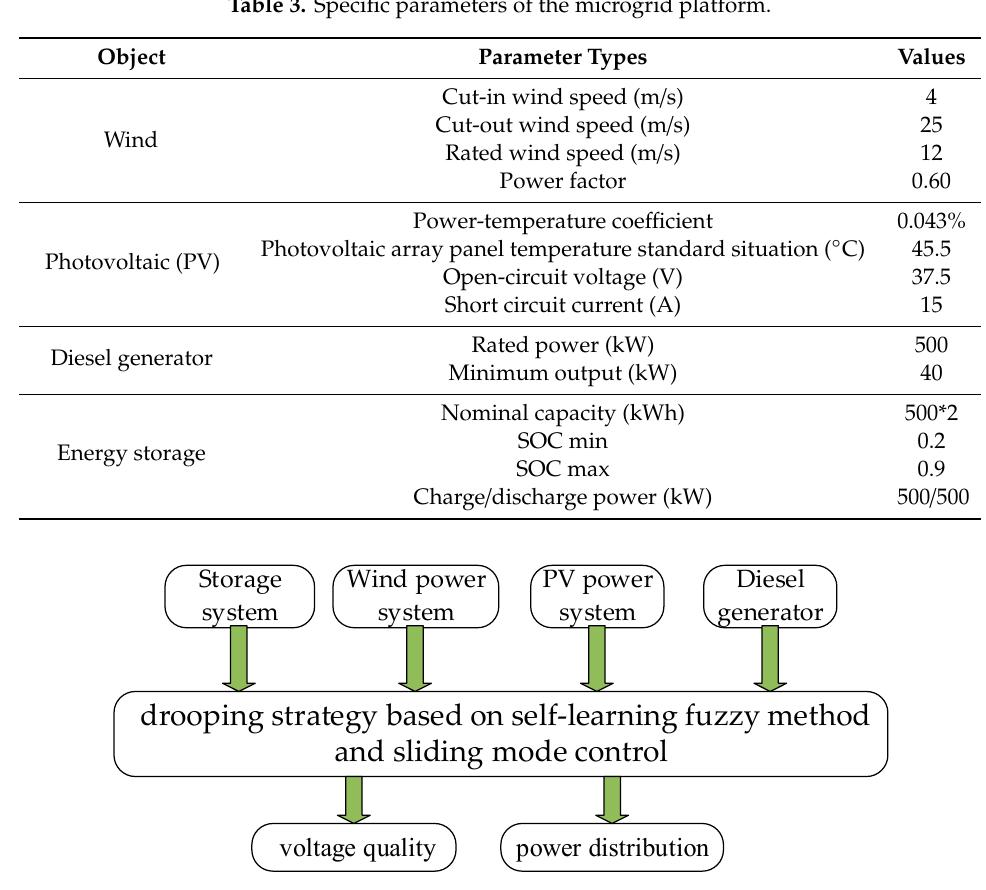
Figure 11. System microgrid model.